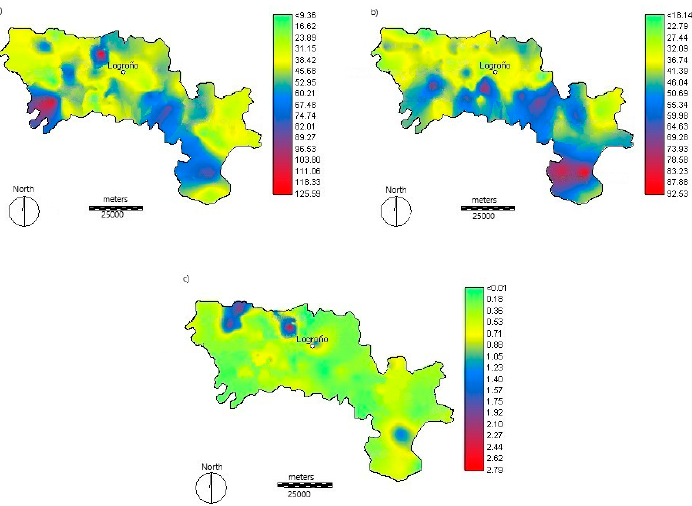
Figure 3. Spatial distribution content of Zn (arithmetic values in mg kg –1 ) observed in the vineyard soils of La Rioja: ( a ) total content in surface, ( b ) total content in depth, and ( c ) bioavailable content in